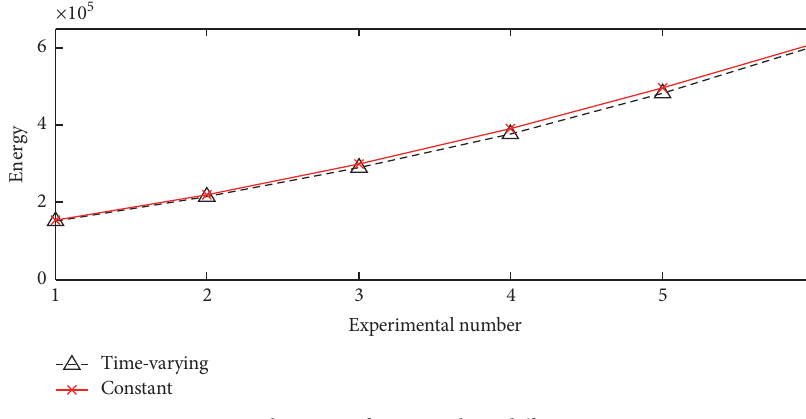
mesh in different input torques. 1